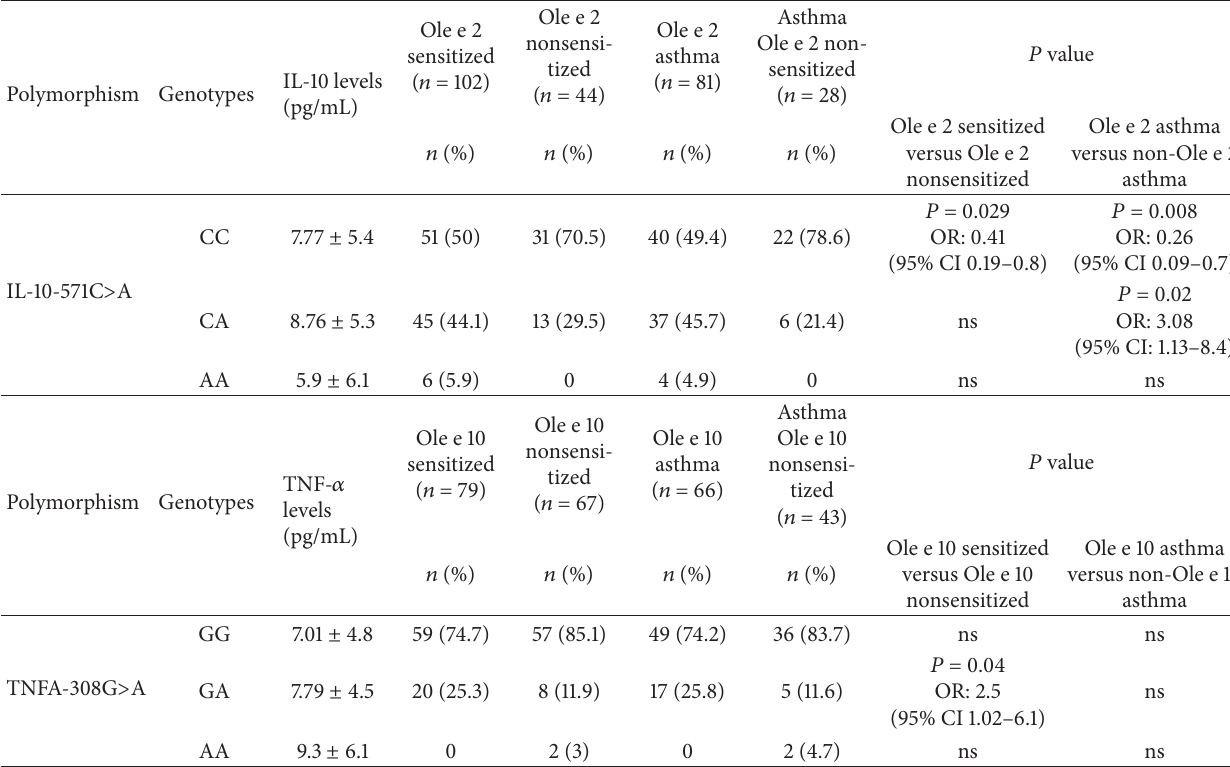
Table 4: Relevant results of TNF- 𝛼 and IL-10 polymorphisms according to Ole e 2 and Ole e 10 sensitization.